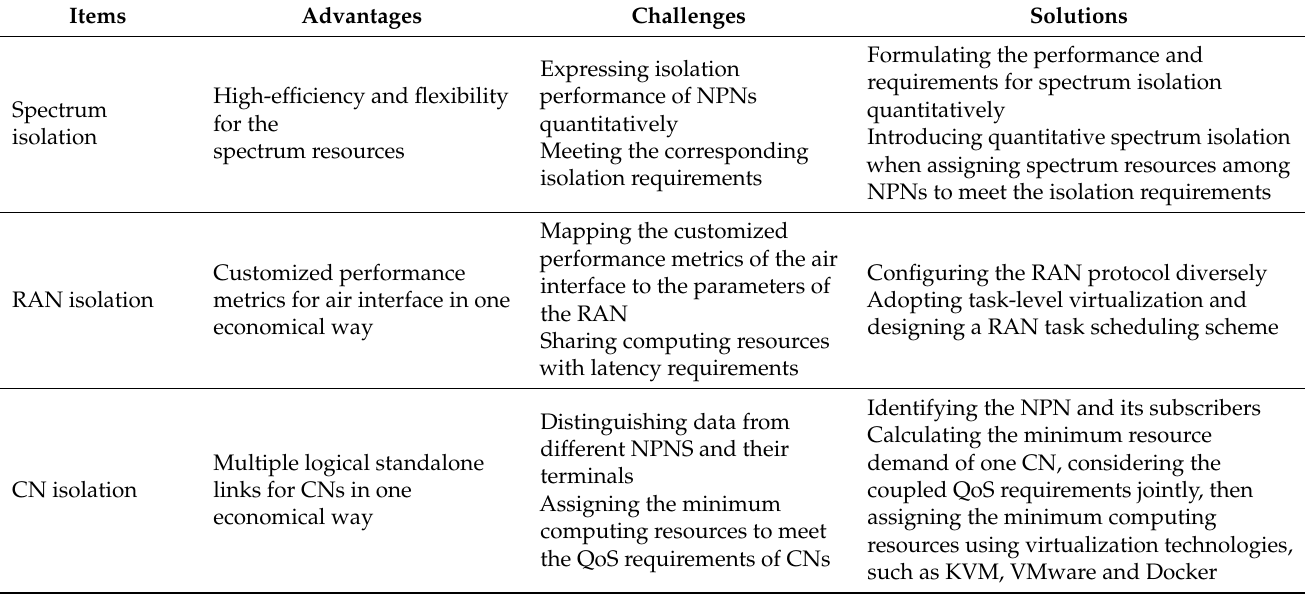
Table 2. Advantages, challenges and solutions for spectrum isolation, RAN isolation and CN